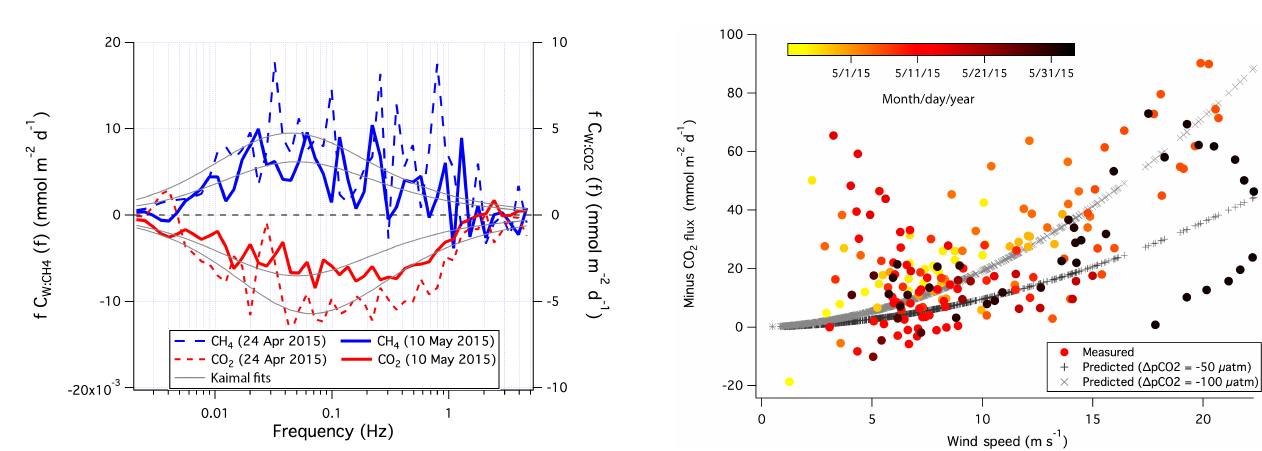
Figure 13. Relationship between CO 2 flux (R3 sonic anemometer; reversed in sign) and wind speed during April–June 2015 (sampling height of 18ma.m.s.l.). Predicted CO 2 fluxes assuming (cid:49)p CO 2 of − 50 and − 100µatm are also shown.